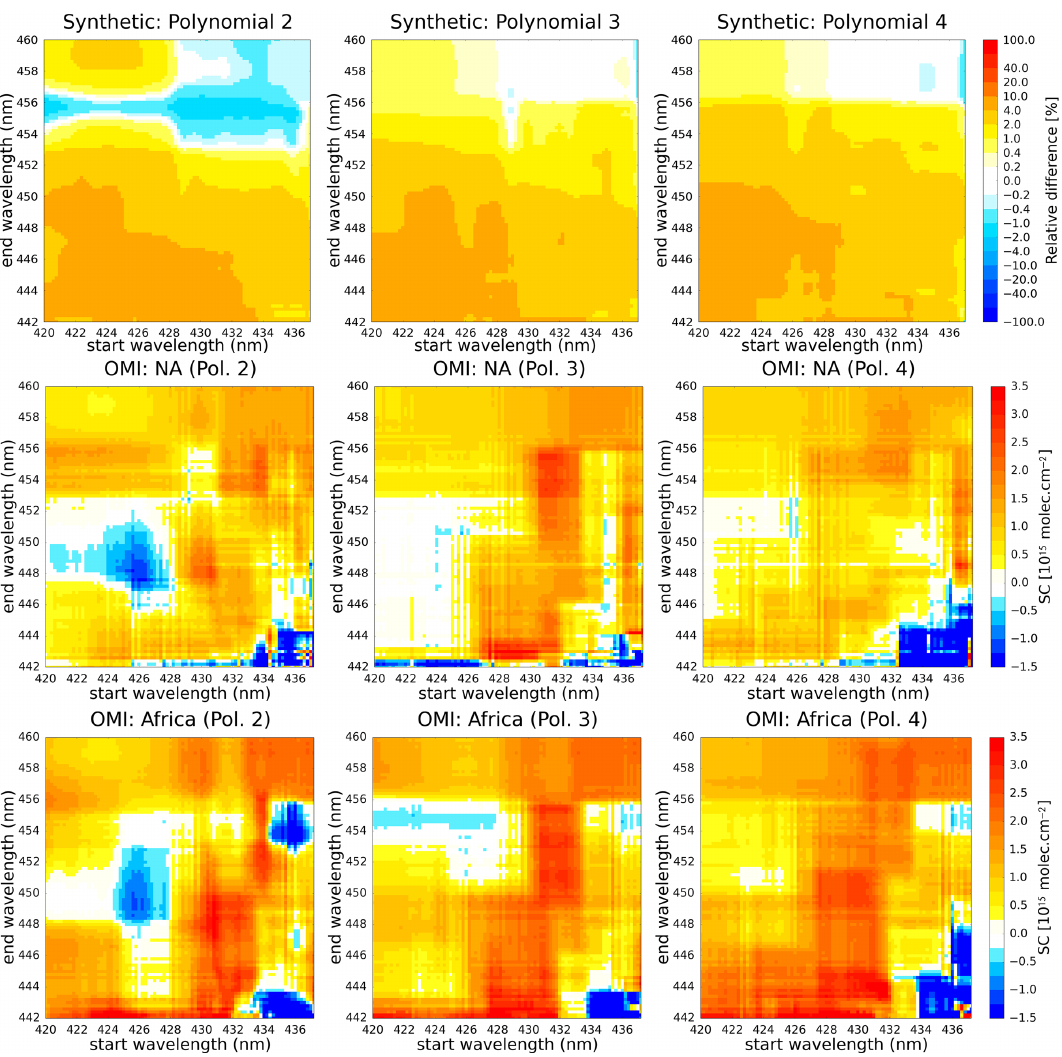
Figure 3. Colour mapping of CHOCHO SC deviation with respect to the a priori (“true value”), retrieved from a synthetic spectrum for wavelength intervals with start limits of 420–437nm, end limits 442–460nm, and polynomial degrees 2, 3 and 4 (top). CHOCHO SC means retrieved over Africa and North America for August 2007 (see Table 1) from OMI measurements for different wavelength ranges and polynomial orders (middle and bottom).